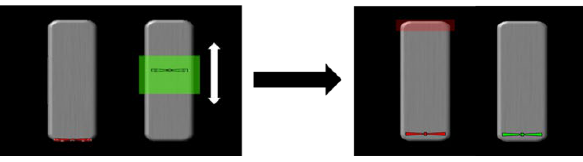
Figure 5. Overview of simulator protocol.